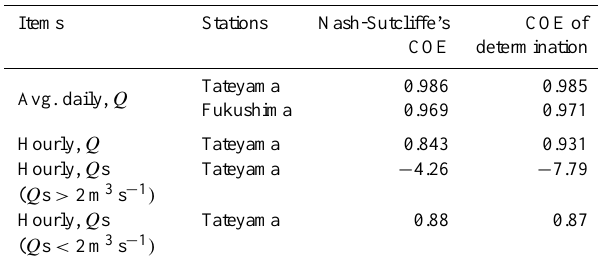
Table 5. Performance evaluation of hydrological and sediment